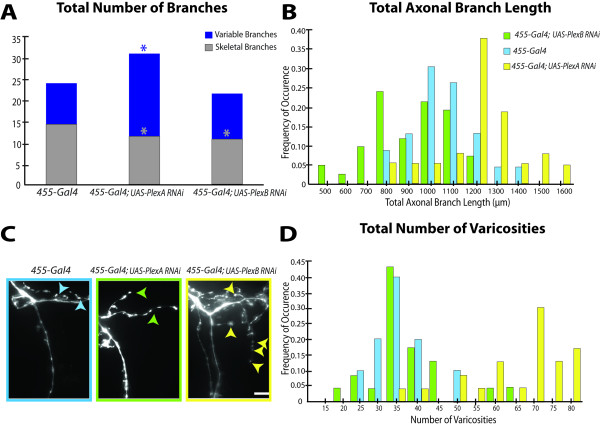
Quantitative analysis of PlexinA and PlexinB branches and varicosities reveals opposing roles in local axonal growth and synapse formation. A, PlexinA RNAi within the pSc neuron increases the number of variable axonal branches, whereas PlexinB RNAi decreases the number of highly stereotyped (skeletal) branches. Significant decreases in the number of highly skeletal pSc branches were also observed in the PlexinA RNAi neurons due to an increase in branch routing errors. Asterisks denote significance of p < 0.05. B, The pSc axonal arbor sizes with PlexinA RNAi are significantly shifted towards larger values. The distribution of pSc arbor sizes with PlexinB RNAi on the other had is shifted towards smaller values. Frequency distributions of the total axonal branch lengths among the three genotypes, 455-Gal4, and 455-Gal4; UAS-PlexA-RNAi, and 455-Gal4; UAS-PlexB-RNAi were significantly different from each other (p < 0.05). The average arbor size for 455-Gal4 control flies was 1045 μm and approximately 30% of flies had total branch lengths of 1000 μm (blue bars). The average arbor size in PlexinB RNAi pSc neurons was 918 μm with 25% of the neurons having total branch lengths of 800 μm (green bars). Reducing PlexinA expression in pSc neurons had the opposite effect, and increased their average total branch lengths to 1219 μm with 35% of arbors at 1200 μm (yellow bars). Histogram bin width, 100 μm. C, Quantification of axonal varicosities is an indirect measure of synaptic contacts. Varicosities (arrowheads) along branches were counted to obtain a lower estimate of synapse number per pSc axon. Scale bar, 5 μm. D, PlexinA knockdown significantly increases varicosities along the pSc axon. Frequency distribution of the number of varicosities in 455-Gal4; UAS-PlexA-RNAi pSc axons (yellow bars) was shifted to the right compared to the 455-Gal4 distribution (blue bars) (p < 0.01), with no significant difference in 455-Gal4; UAS-PlexB-RNAi (green bars) compared to control.